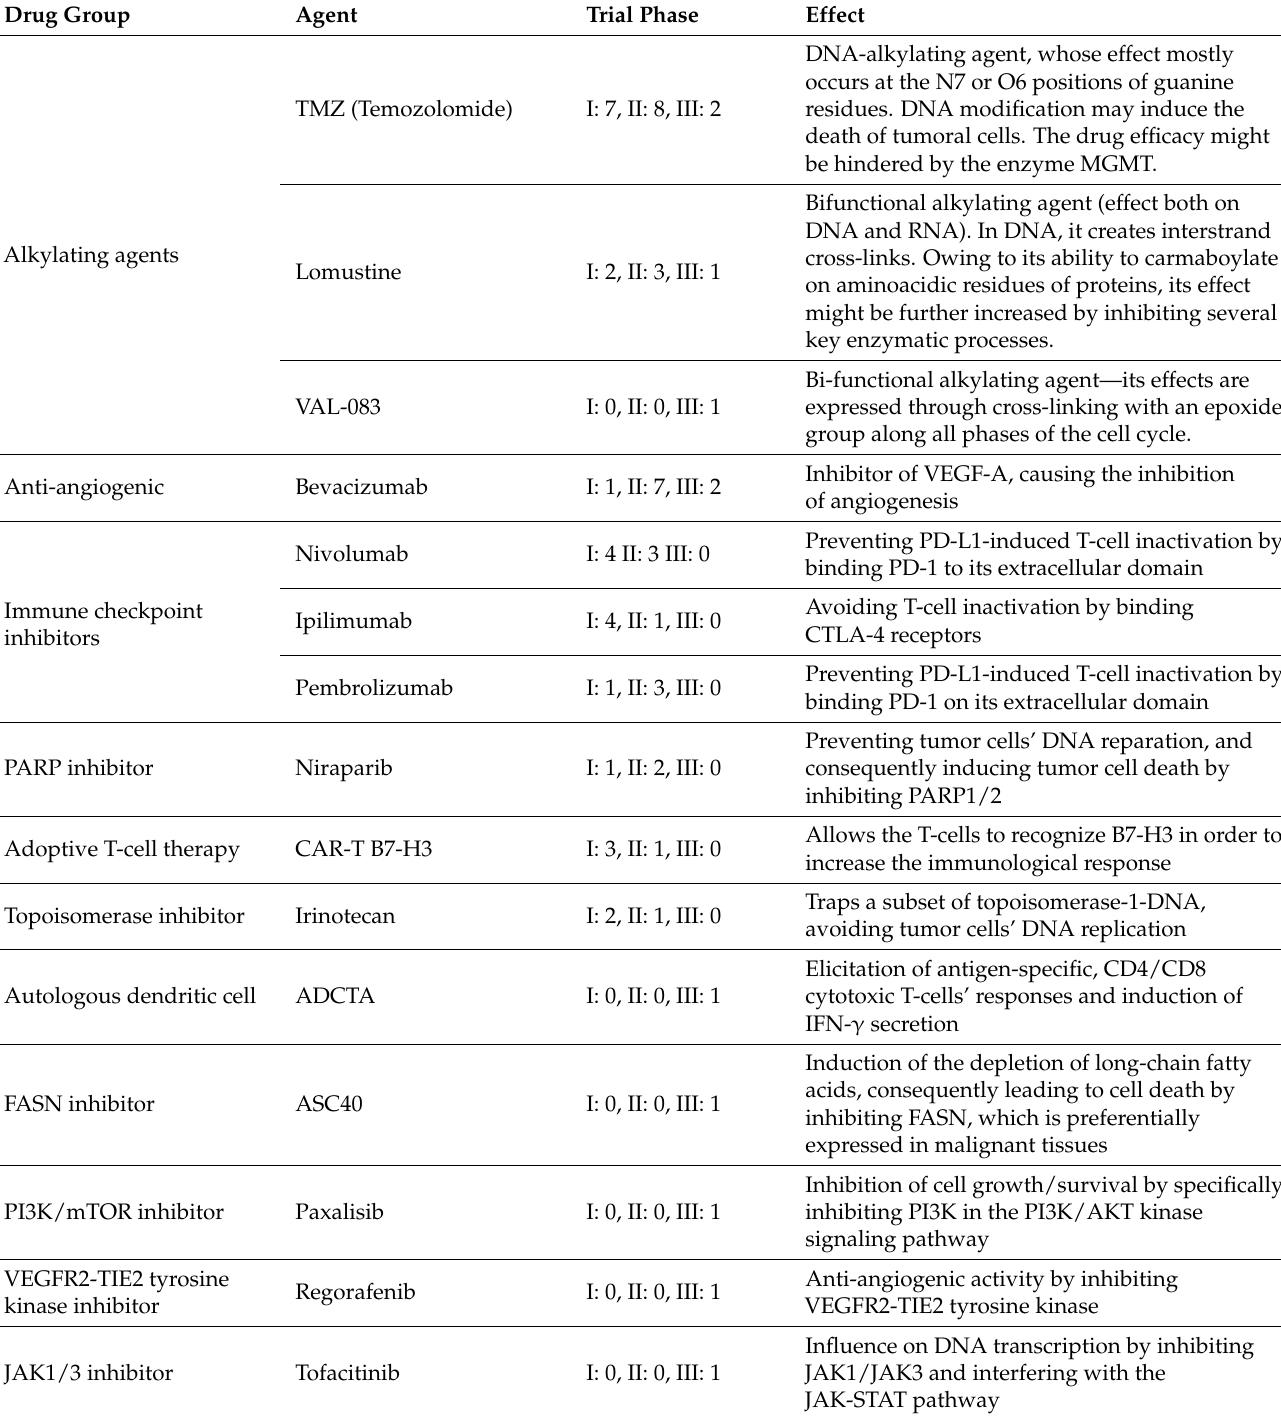
Table 2. Most represented drugs in clinical